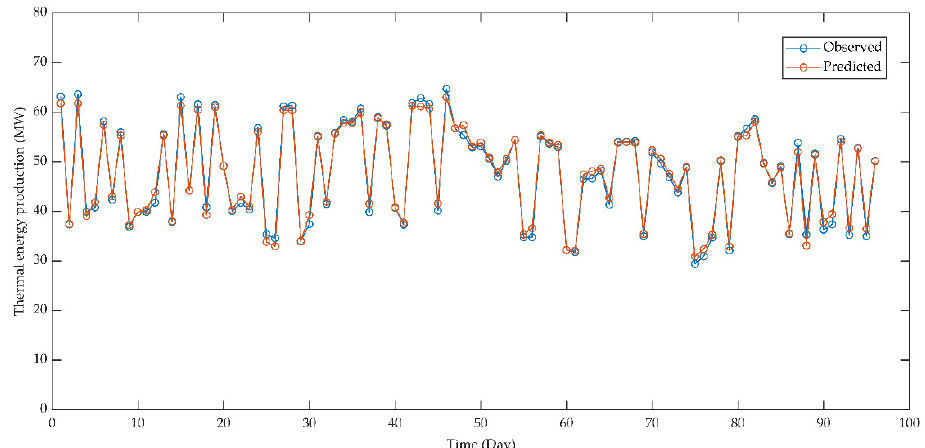
Figure 17. Observed and predicted values of thermal energy production for multilayer perceptron neural network model.